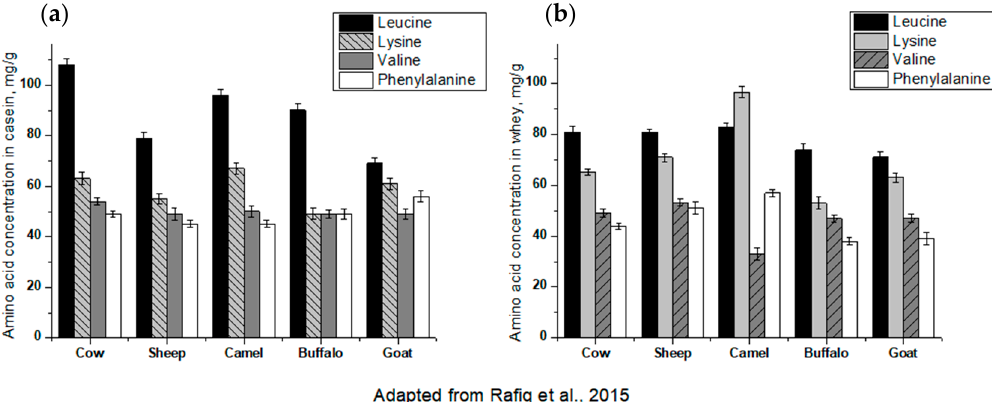
Figure 1. ( a ) Essential amino acids in caseins from different species. ( b ) Essential amino acids in whey from different milk species. (adapted from [14]).